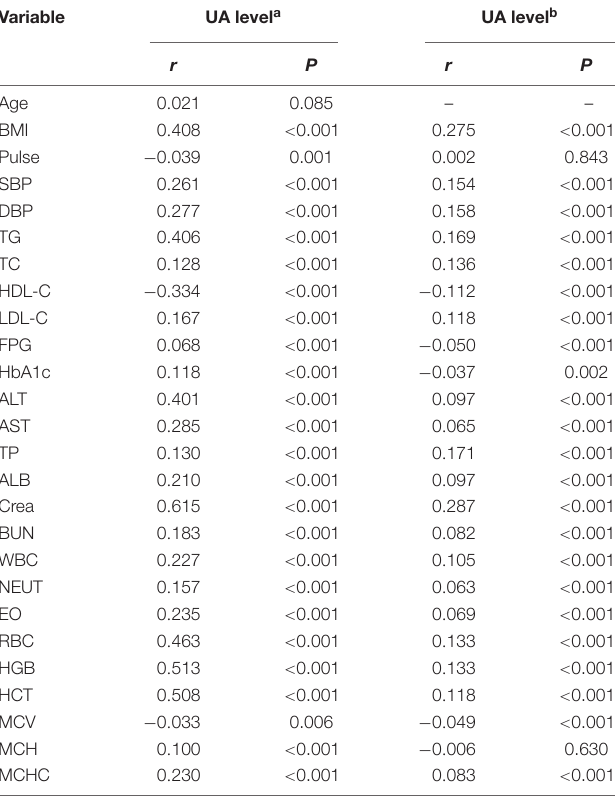
TABLE 4 | The association between hyperuricemia and overweight/obese and metabolic dysfunction in all